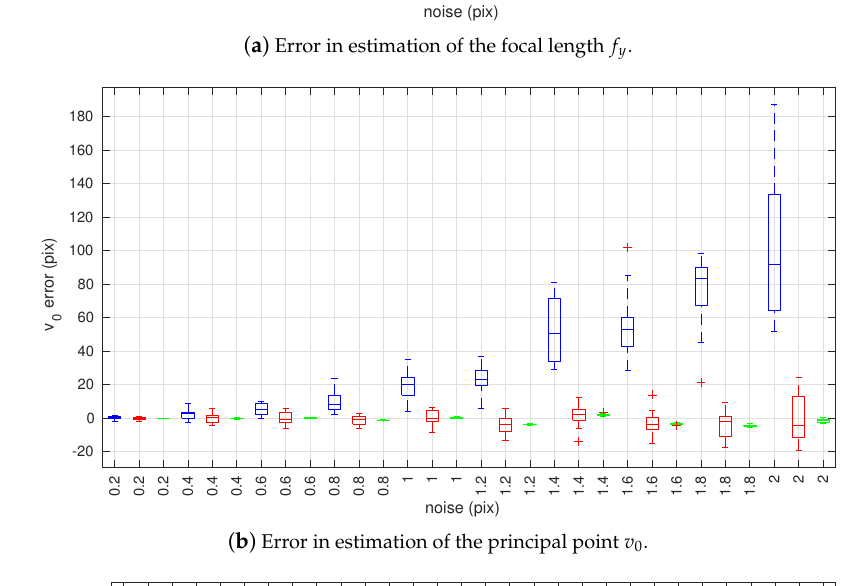
( b ) Error in estimation of the principal point v 0 .